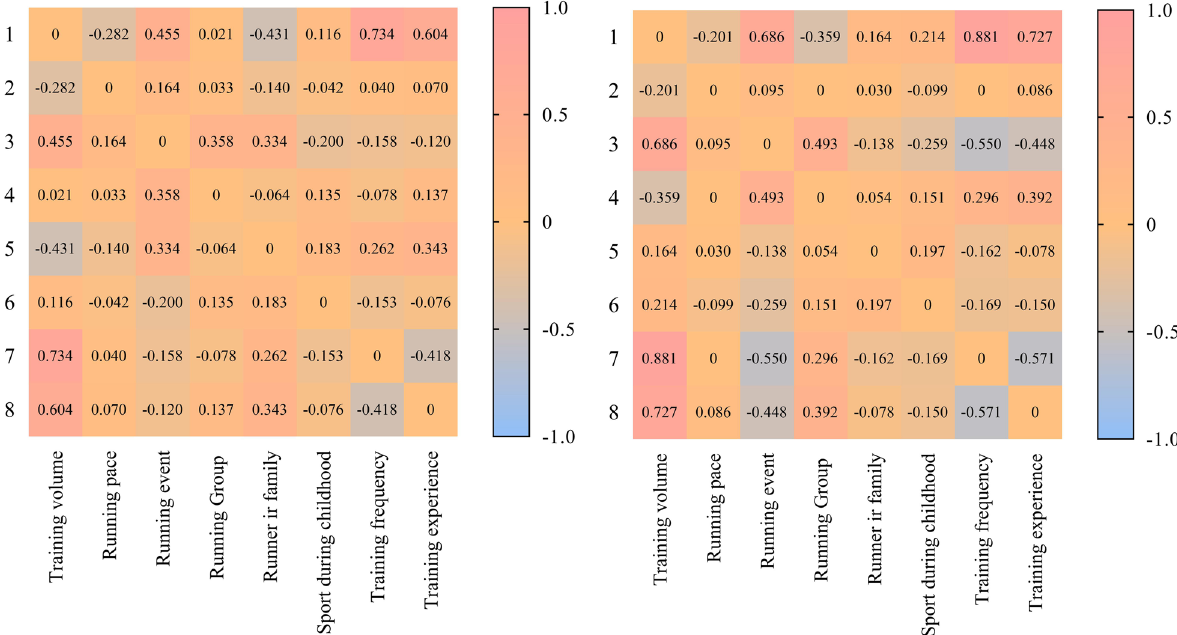
Fig. 2 Correlation matrix for both sexes (left panel: women; right panel: